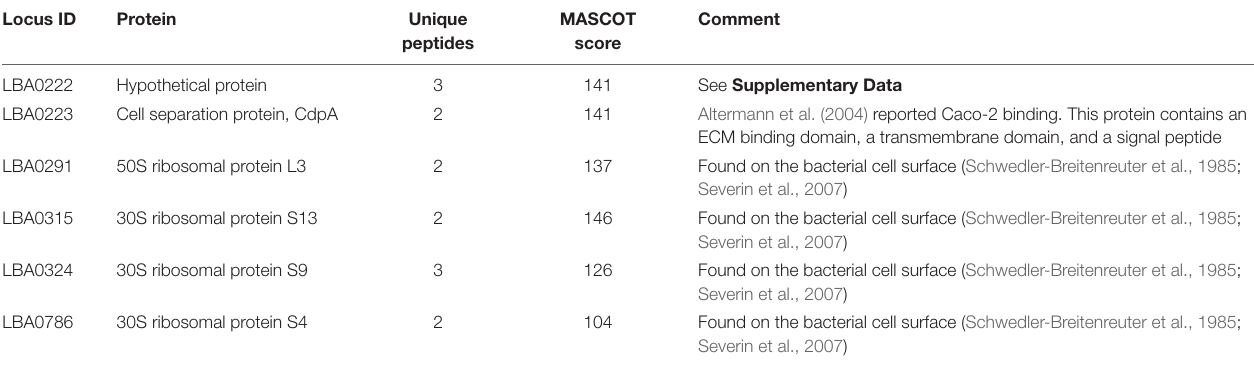
TABLE 1 | Fibronectin binding proteins identified in L. acidophilus NCFM using whole cell cross-linking with an individual protein. Locus ID Protein